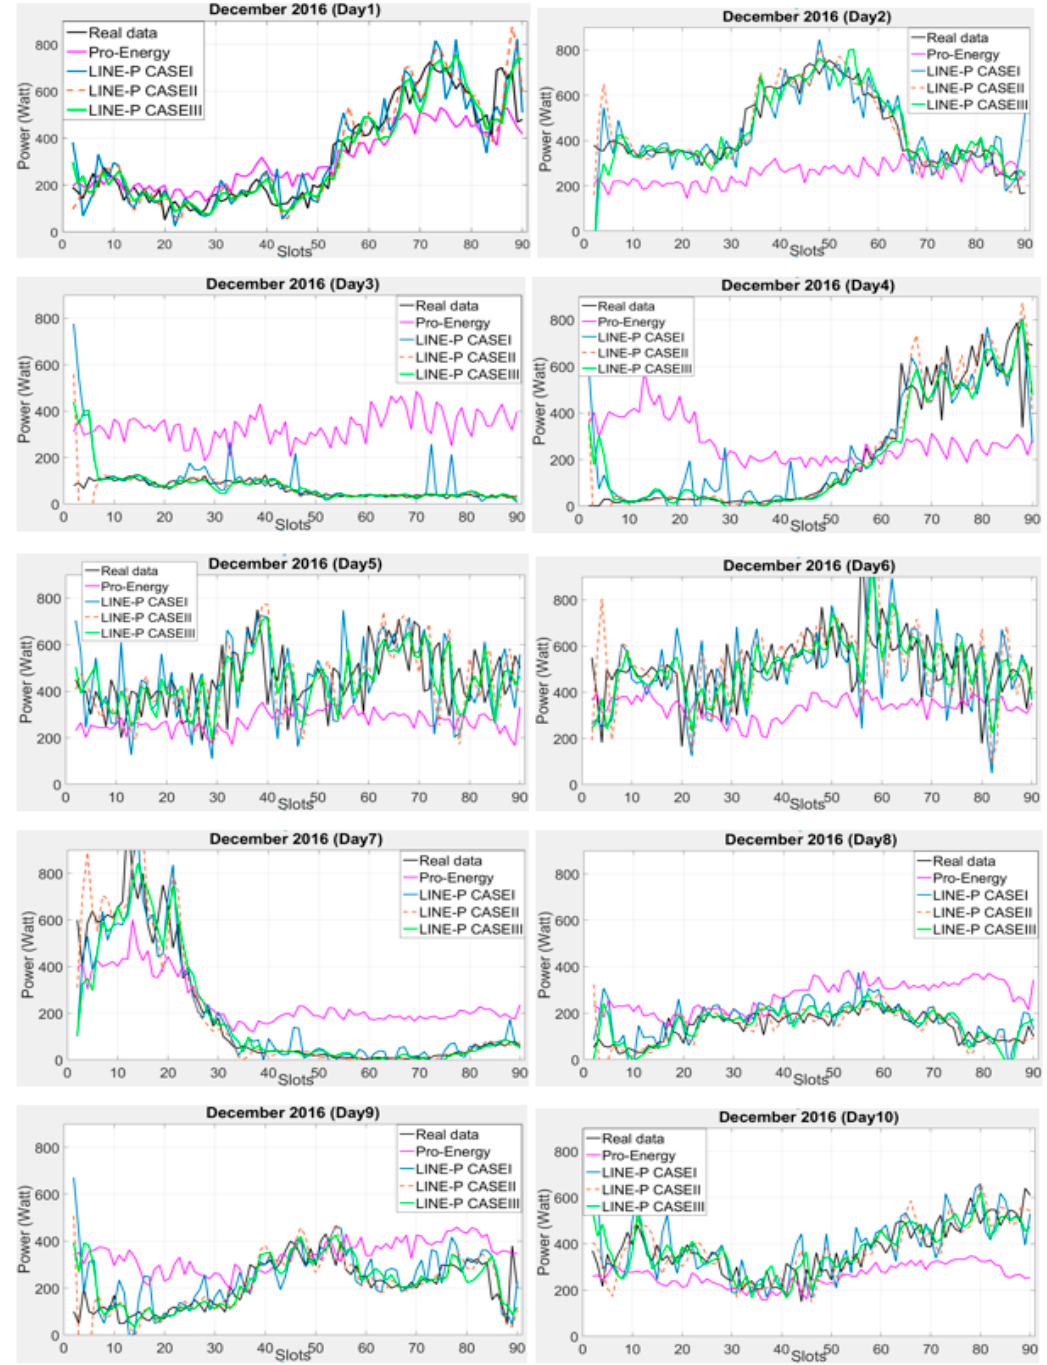
Figure 4. Graphical comparison of the obtained predictions for LINE-P (all cases) and Pro-Energy for shorter interval-based (90 slots) wind energy in December for dataset [9]. Generally speaking, LINE-P yields more accurate estimates than Pro-Energy.